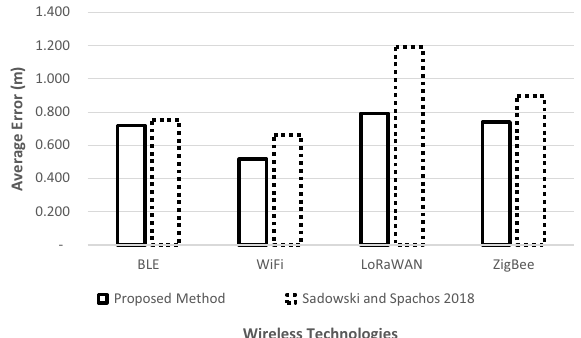
Fig. 9 Comparison of the average position